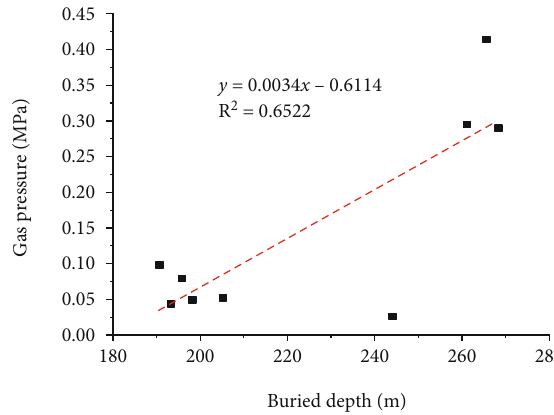
Figure 3: Regression trend line between gas pressure and coal seam buried depth.